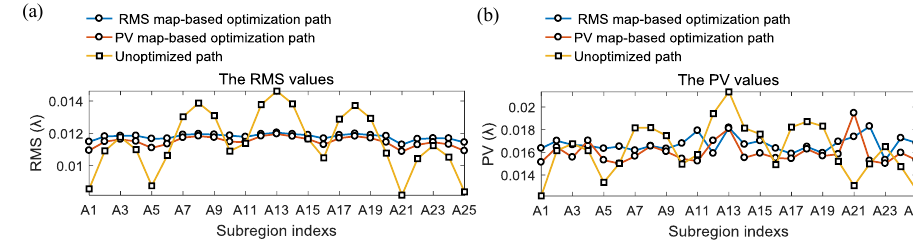
Figure 11. ( a ) RMS and ( b ) PV curves for sub-regional